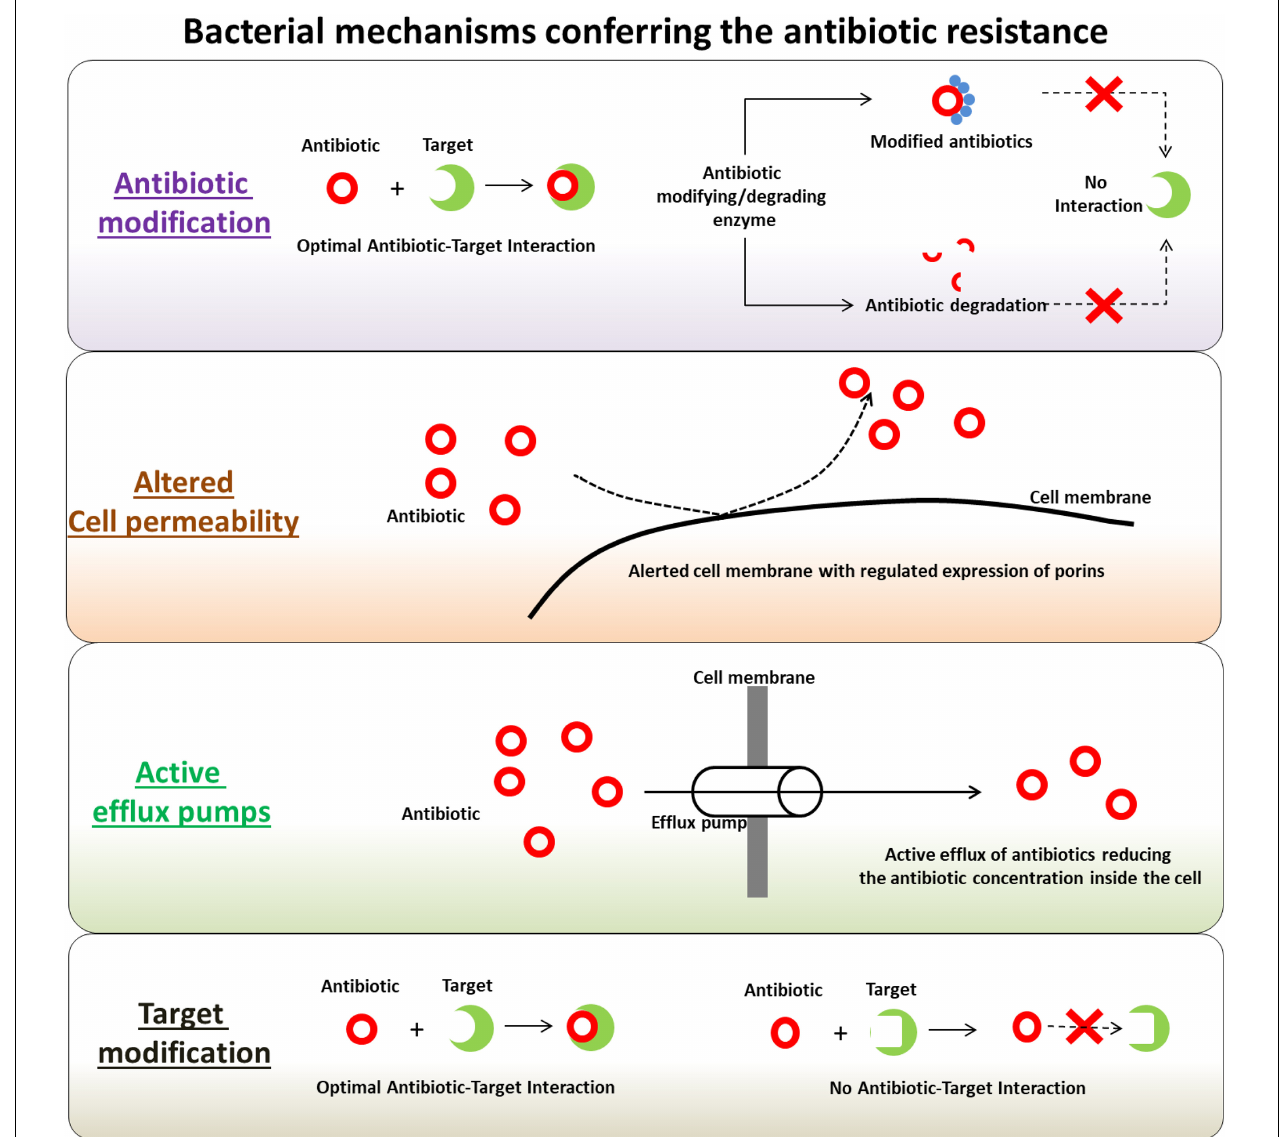
FIGURE 1 | Major bacterial drug resistance mechanisms. Adapted from Khare et al. (2021a). Copyright (2021) Frontiers